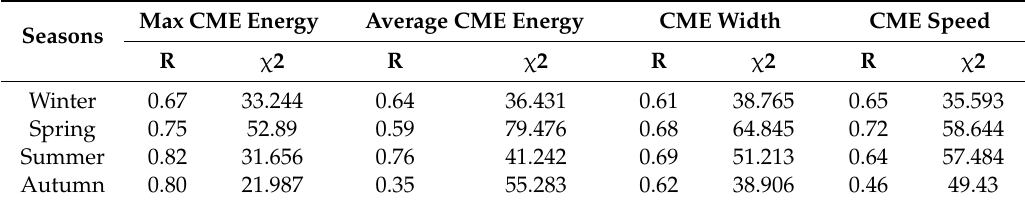
average values of the CME width and